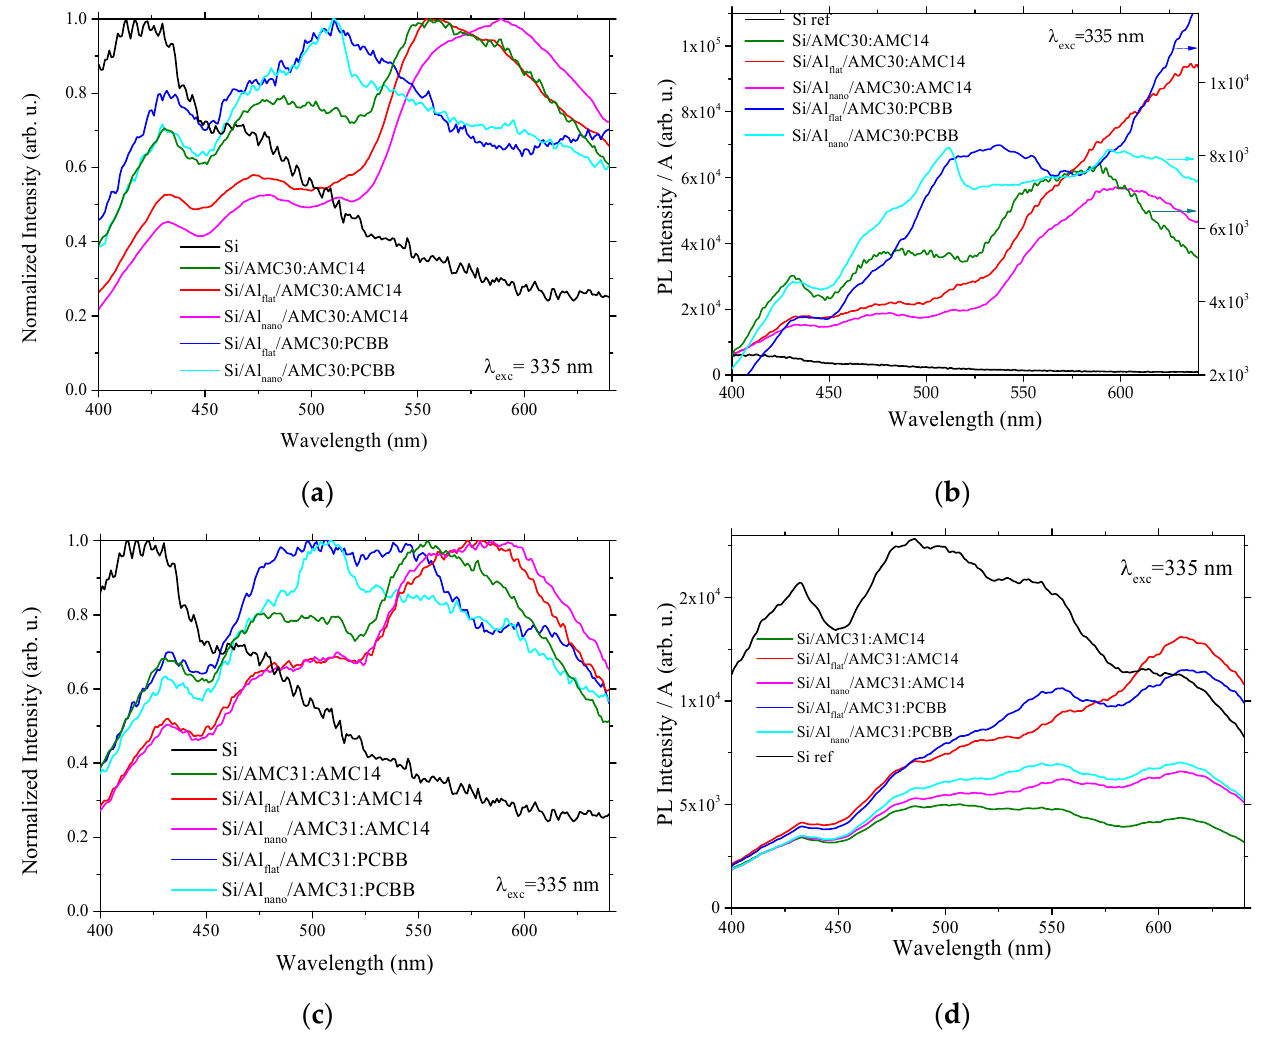
Figure 7. Photoluminescence spectra at excitation with λ = 335 nm of: AMC30:PCBB and AMC30:AMC14 on Al flat and Al nano normalized to PL maximum ( a ); AMC30:PCBB and AMC30:AMC14 on Al flat and Al nano divided by absorbance in reflection ( b ); AMC31:PCBB and AMC31:AMC14 on Al flat and Al nano normalized to PL maximum ( c ); AMC31:PCBB and AMC30:AMC14 on Al flat and Al nano divided by absorbance in reflection ( d ). A = Absorbance.